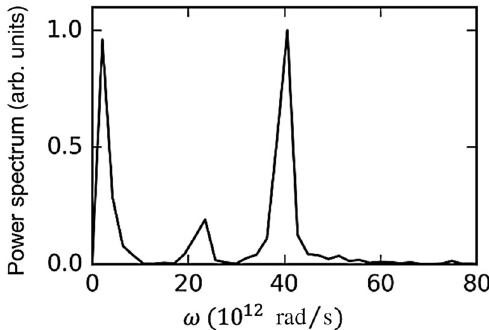
FIG. 4. Power spectrum (squared amplitude of the Fourier transform) of Fig.